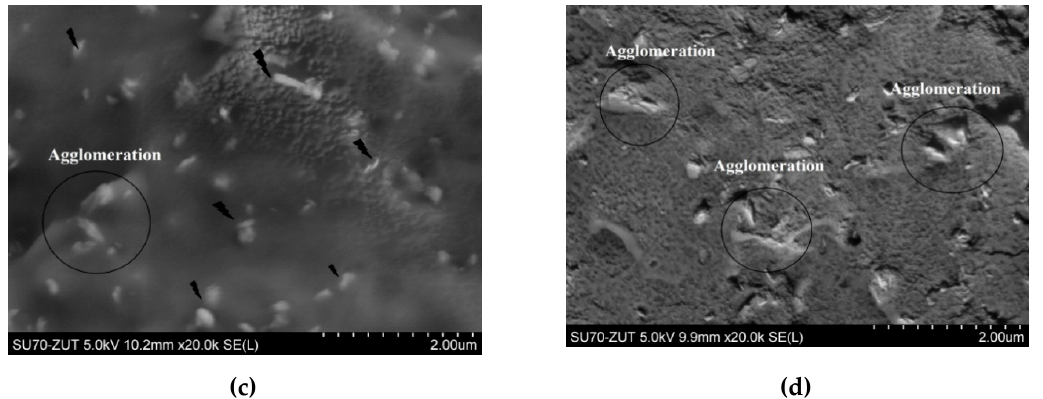
Figure 3. SEM images of PP/HNT NCs ( a ) 1 vol.%, ( b ) 2 vol.%, ( c ) 5 vol.%, and ( d ) 10 vol.% of HNTs.